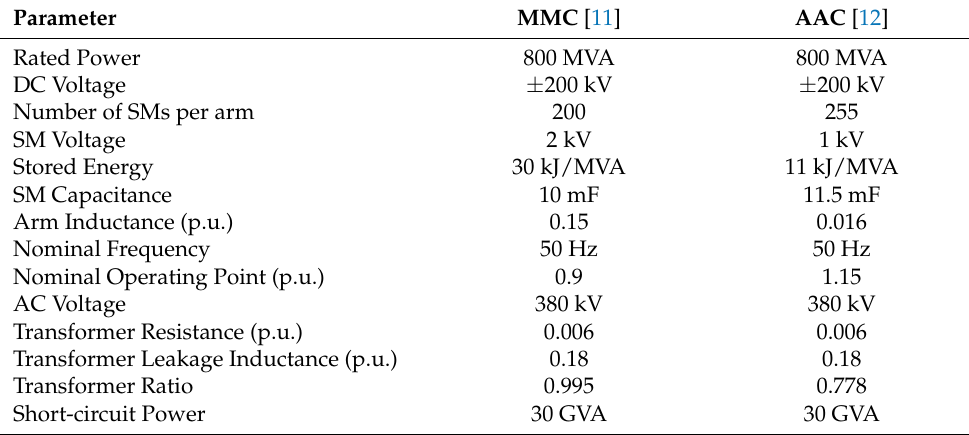
Table 1. Parameters of the MMC and AAC-based converter